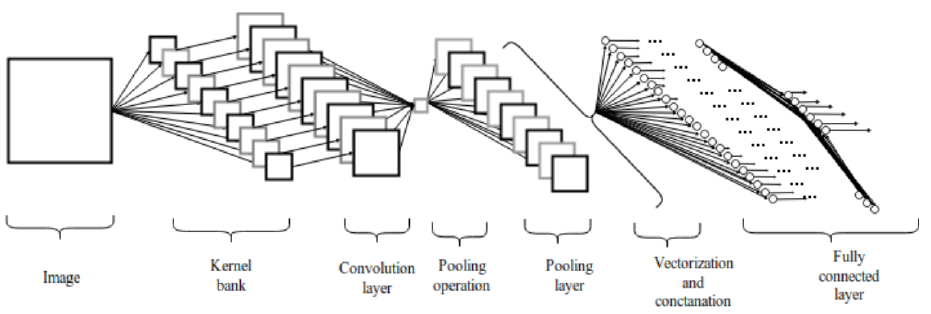
Figure 1. CNN network structure